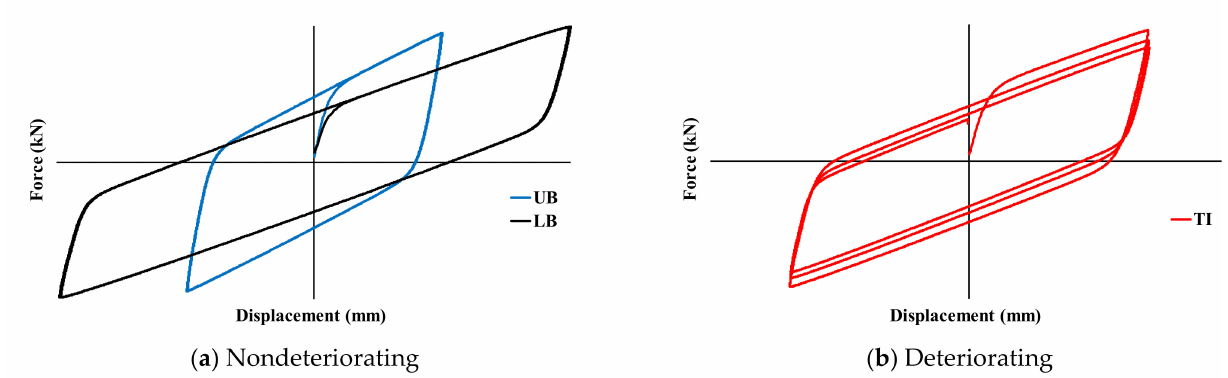
Figure 7. Analytical representation of deteriorating and non-deteriorating hysteretic behavior of lead rubber